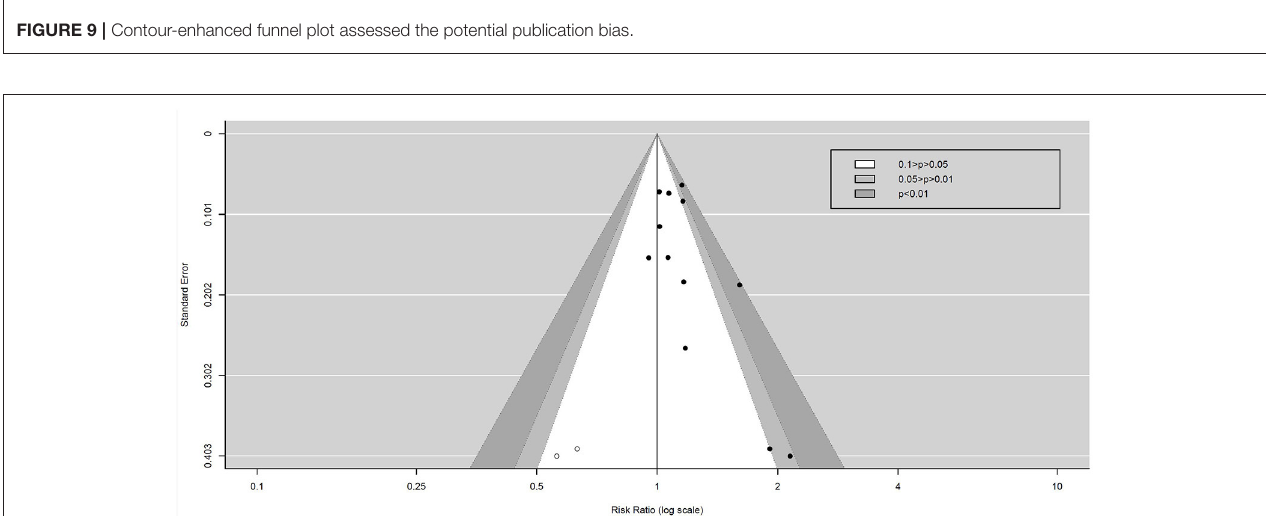
FIGURE 10 | Contour-enhanced funnel plot combined with trim